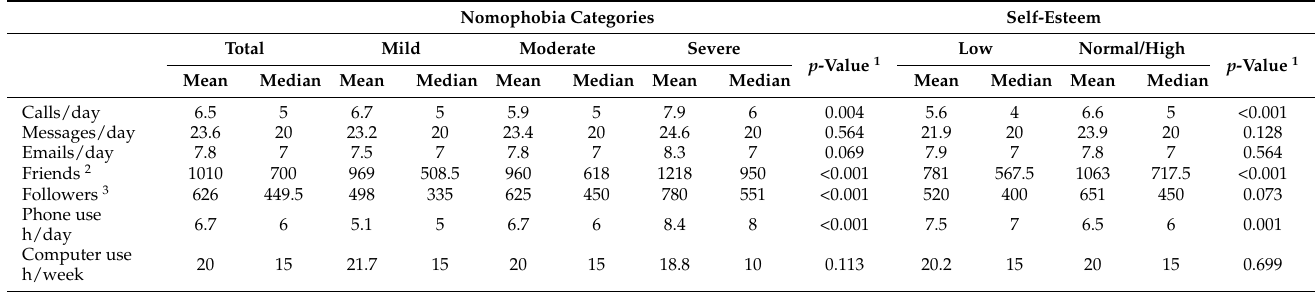
Table 3. Mobile phone use by NMP and self-esteem categories.